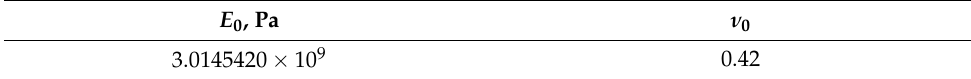
Table 8. Instantaneous properties of viscoelastic material.